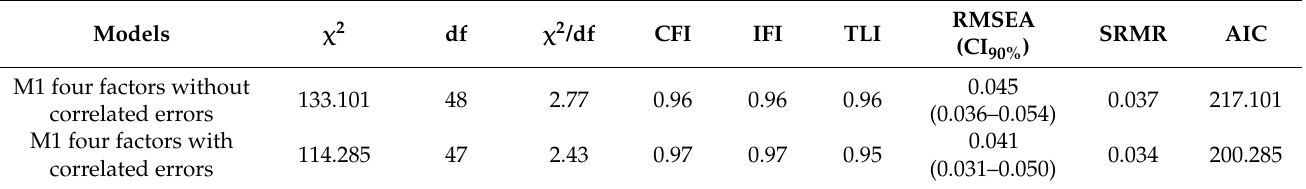
Table 1. Goodness-of-fit of confirmatory factor analysis